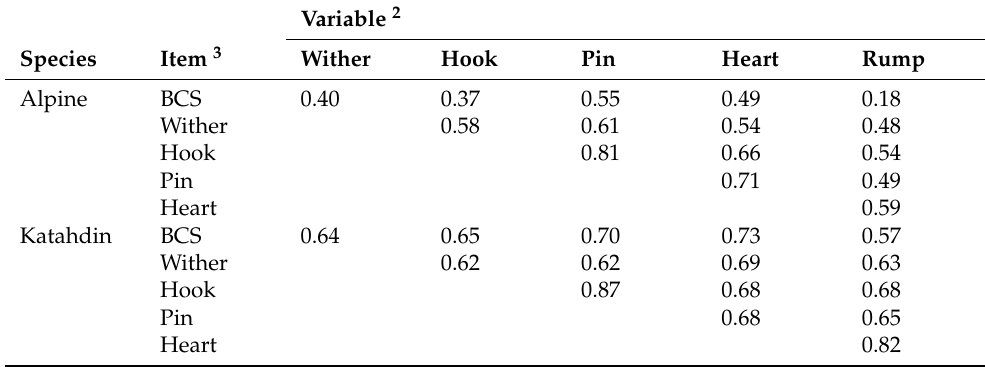
Table 2. Pearson correlation coefficients (r) between body condition score and linear measures 1